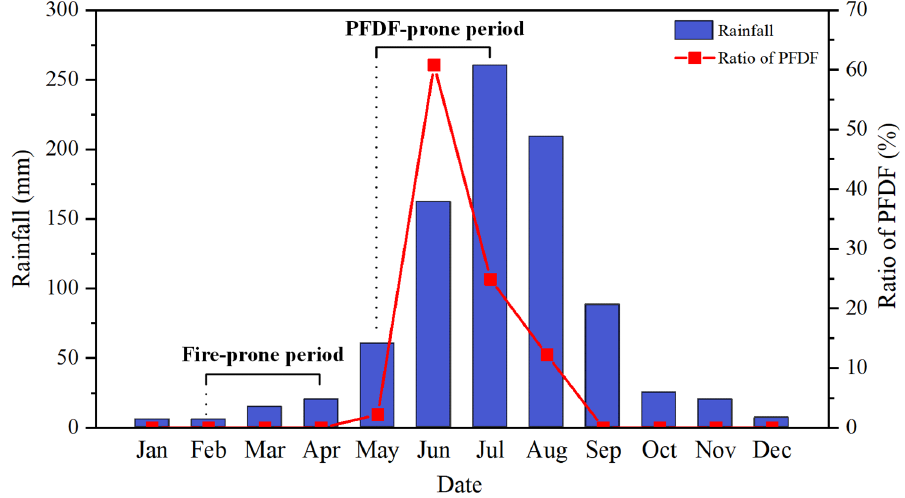
Figure 3. Monthly distribution of rainfall and PFDF occurrence ratio in the study area in 2020.